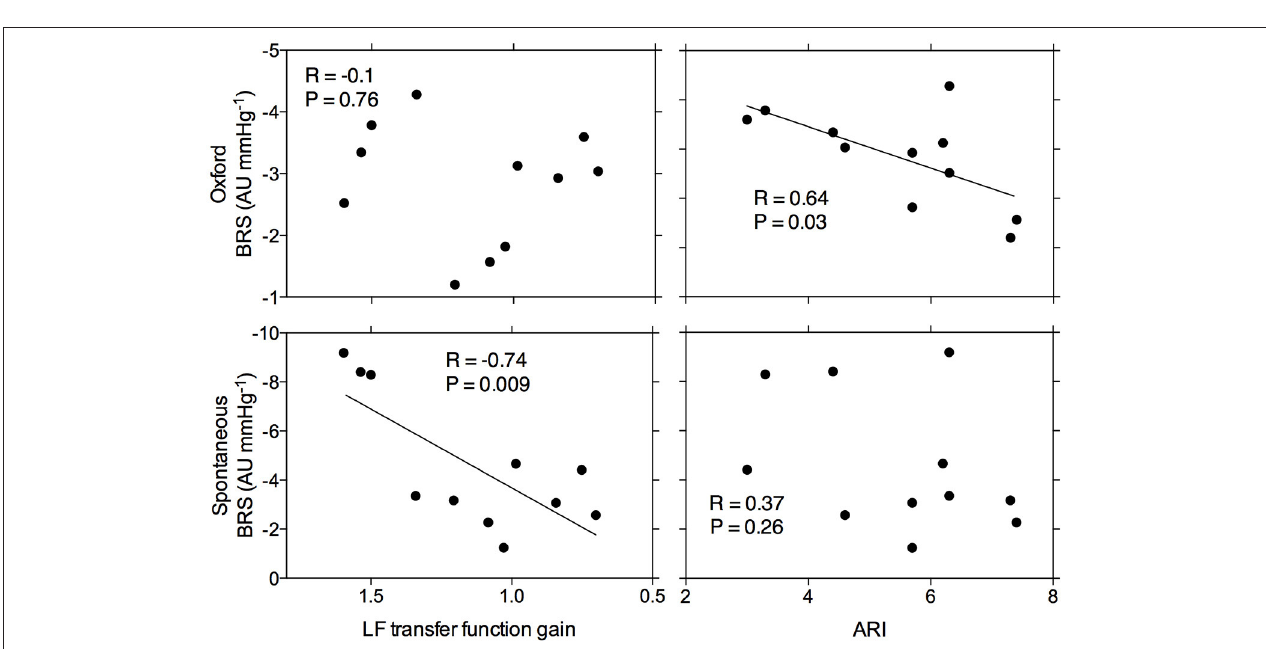
FIGURE 2 | Relationship between arterial baroreflex sensitivity as assessed by the modified Oxford method and spontaneously and cerebral autoregulation as assessed by Tiecks’ Autoregulatory Index and transfer function analysis gain. (LF = low frequency). Each point represents data for a given